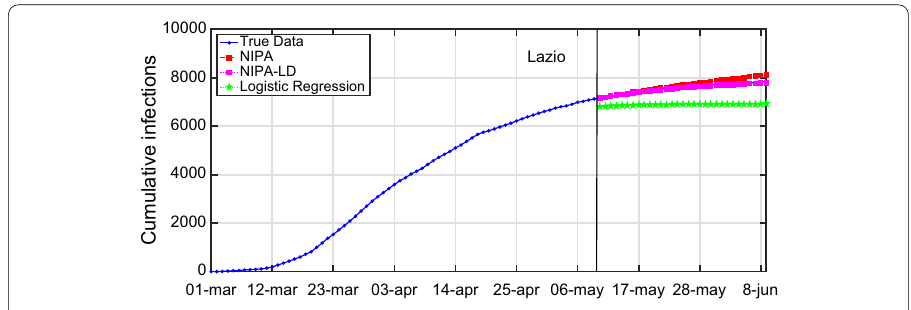
Fig. 7 Cumulative infections for Lazio